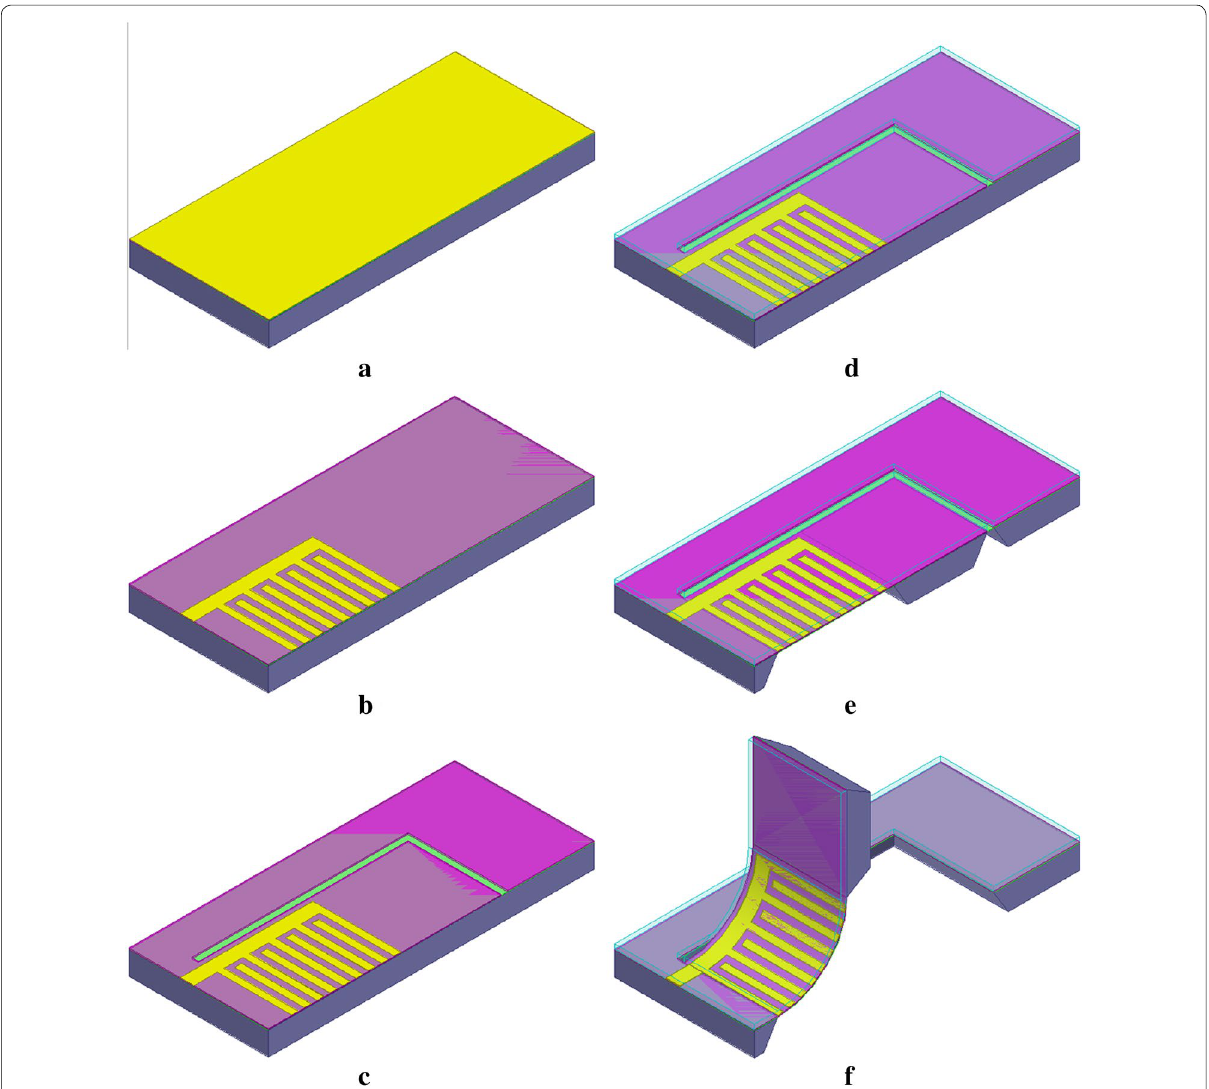
Fig. 3 Fabrication of flexible PZT based energy harvester: a deposition of SiNx/LTO, PZT/PbTiO3 and Pt on Si wafer, b Pt etching for IDT electrodes, c PZT wet etching, d depositing and defining the cantilever by using photo-definable polyimide, e KOH wet etching to form the proof mass, f SiNx/ LTO etching by RIE for